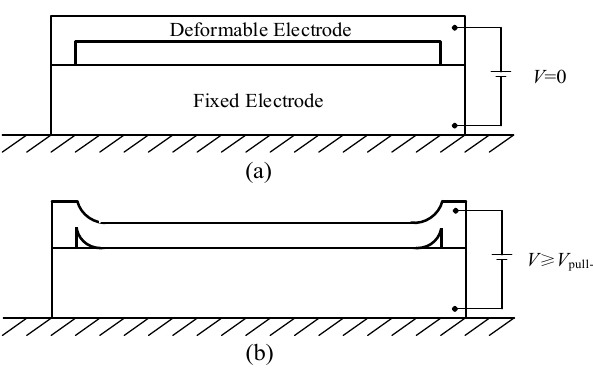
Figure 1. Pull-in effect. ( a ) Initial structure without voltage bias and ( b ) attached structure with a voltage bias beyond pull-in voltage.